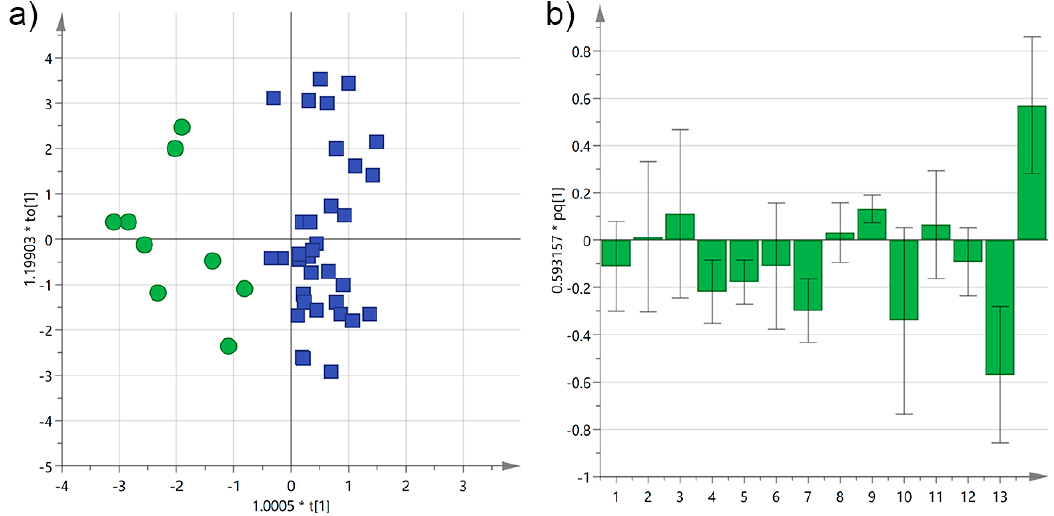
Figure 10. ( a ) OPLS-DA score plot for EVOO samples from Salento categorized by the age of the olive trees (green circles ≤ 100 years; blue squares > 100 years); ( b ) OPLS-DA loadings column plot for the first predictive component of the model (variables: 1 = total biophenols; 2 = hydroxytyrosol; 3 = tyrosol; 4 = 3,4-DHPEA-EDA; 5 = 3,4-DHPEA-EA; 6 = lignans; 7 = luteolin; 8 = p -HPEA-EDA; 9 = p -HPEA-EA; 10 = 3,4-DHPEA-EA in the mixed aldehydic and hydroxylic form; 11 = p -HPEA-EA in the mixed aldehydic and hydroxylic form; 12 = α -tocopherol; 13 ≤ 100 years; 14 > 100 years).